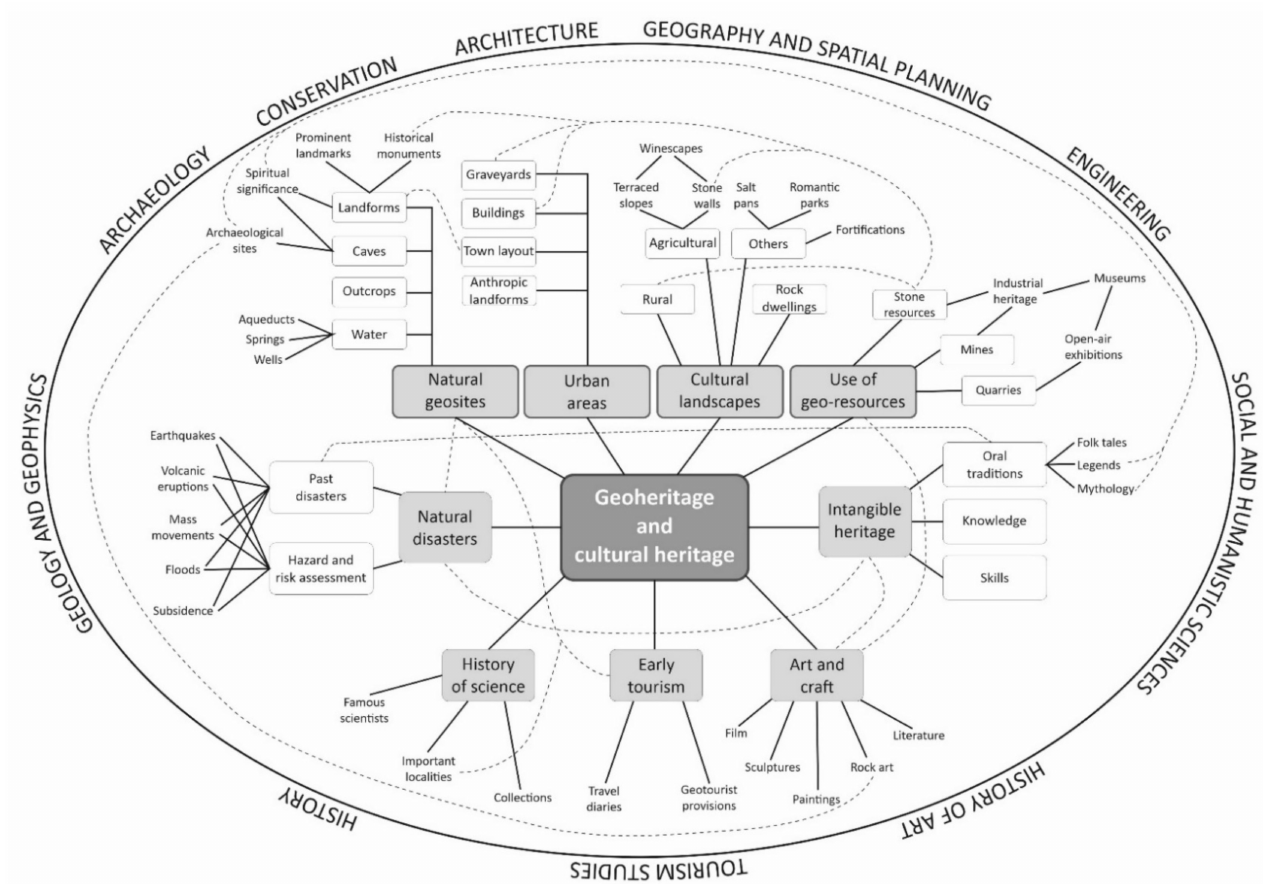
Figure 8. Themes explored at the geoheritage—cultural heritage interface, divided into main (framed by thicker lines) and secondary ones, and the most evident connections between specific subjects (dashed lines). The outer ellipse shows sciences whose fields of interest overlap with geoheritage